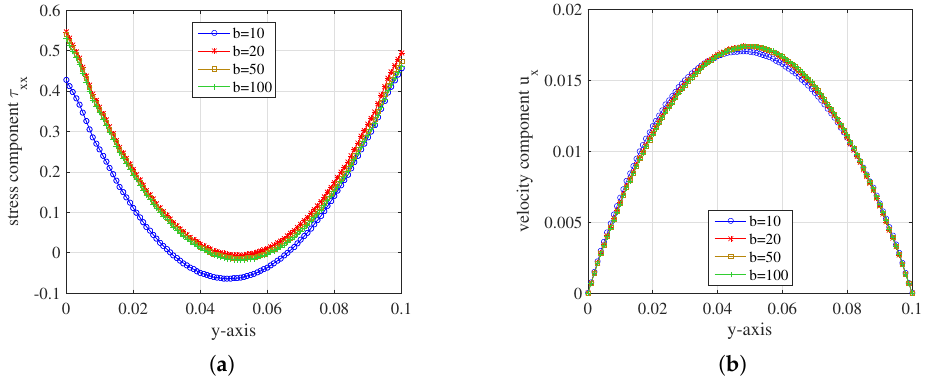
Figure 13. ( a ) Stress component τ xx ; and ( b ) velocity component u x on the y -axis during the steady state at t = 1.999185 for different dumbbell’s extension parameter b of FENE